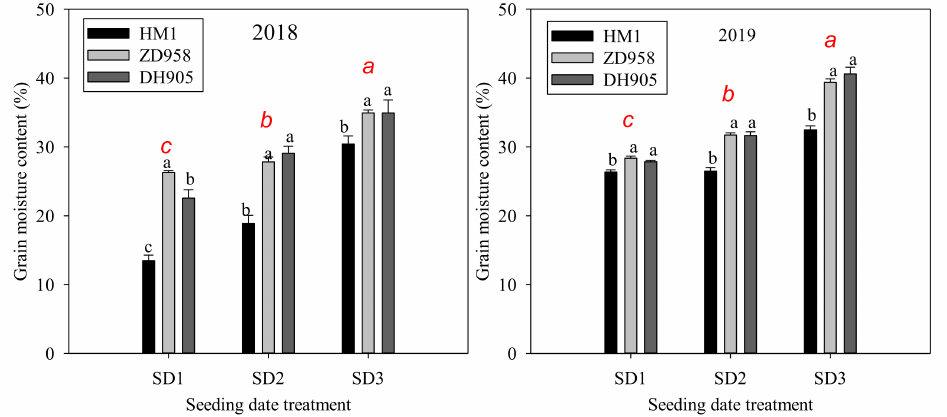
Figure 6. Grain moisture contents of tested cultivars at harvest under different seeding date. SD1, SD2, and SD3 represent the sowing dates of 10 June, 17 June, and 24 June, respectively. Different lowercase letters above the columns within the same sowing date indicate significant difference between cultivars. Different lowercase letters in red italics above the columns indicate significant difference between sowing